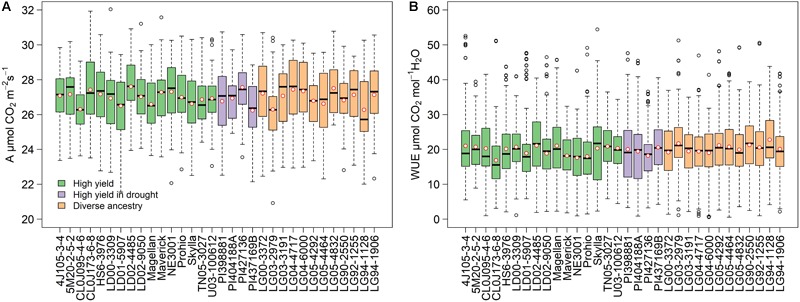
Phenotypic diversity for photosynthesis (A) and intrinsic water use efficiency (B) grouped by family in a soybean phenology-controlled panel. Three hundred and eighty-three cultivars, 12 cultivars per family, and three environments. Colors represent the type of population assigned to the parent when the SoyNAM panel was developed. Red circles denote the mean value, horizontal lines in the box indicate the median, dashed lines represent the minimum and maximum values, and empty circles correspond to outliers.